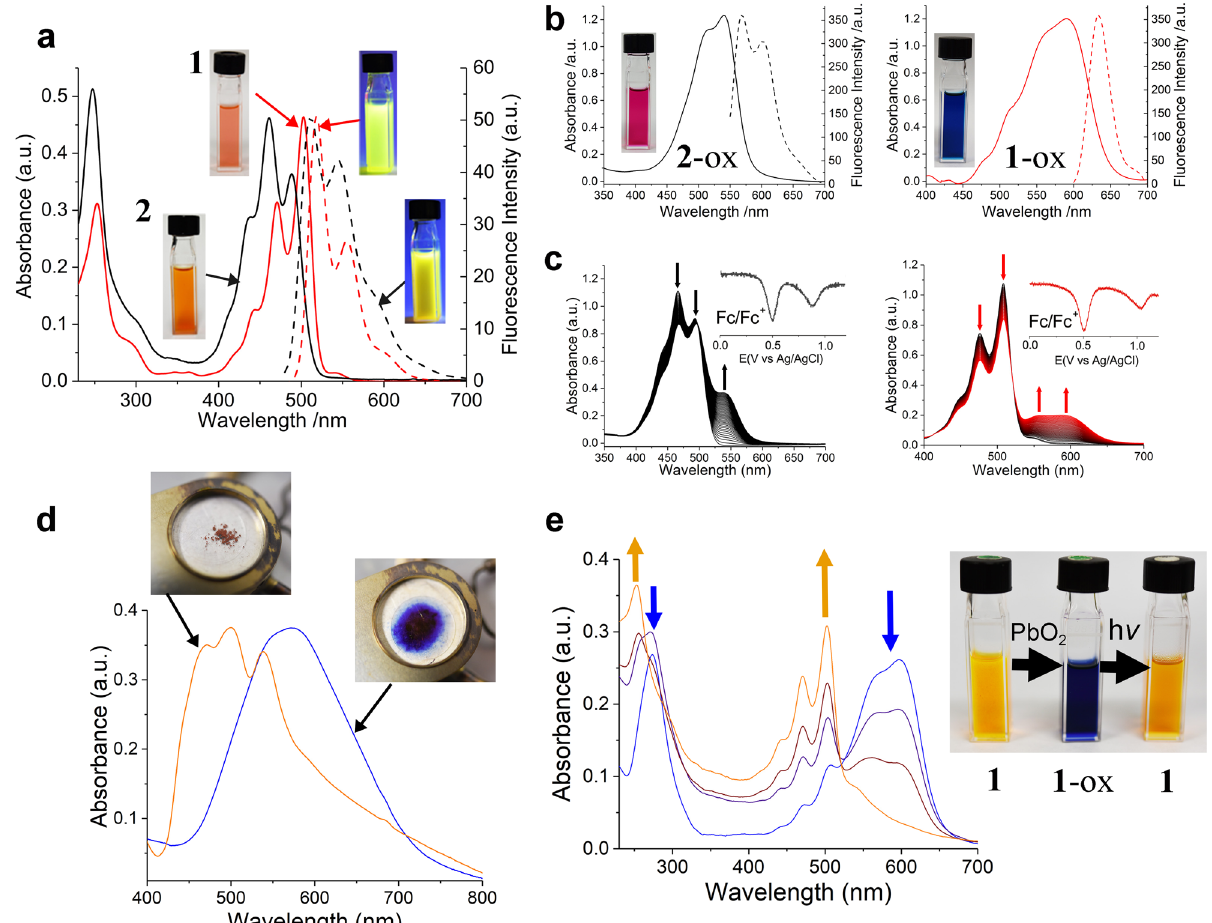
Fig. 5 Redox state identi fi cation of pyrazinacenes 1 and 2 in the solution phase. a UV/Vis (solid lines) and fl uorescence emission spectra (dashed lines) of 1 and 2 in dry CH 2 Cl 2 . Insets show photographs of solutions under room light and 365 nm ultraviolet light. b UV/Vis (solid lines) and fl uorescence emission spectra (dashed lines) of 1 -ox and 2 -ox prepared by respective treatment of 1 and 2 with PbO 2 in CH 2 Cl 2 . Insets show photographs of the respective solutions under room light. c Spectroelectrochemistry of (left) 2 and (right) 1 in benzonitrile with applied positive potential of 1.0 V. Insets of c show the respective differential pulsed voltammograms. d Thermally induced oxidation in air: variation in solid state UV/Vis spectrum of 1 prior to (orange line) and following (blue line) heating in air at 370 °C. Insets show photographs of the corresponding solid states. e Photoreduction of 1 -ox in CH 2 Cl 2 promoted by irradiation from a Hg/Xe lamp; the UV/Vis spectrum of the reduced state of 1 is re-emerging. Blue arrows denote the decreasing intensity of the peaks corresponding to the oxidized form 1 -ox, orange arrows denote the emerging intensity of the peak associated with the native form, 1